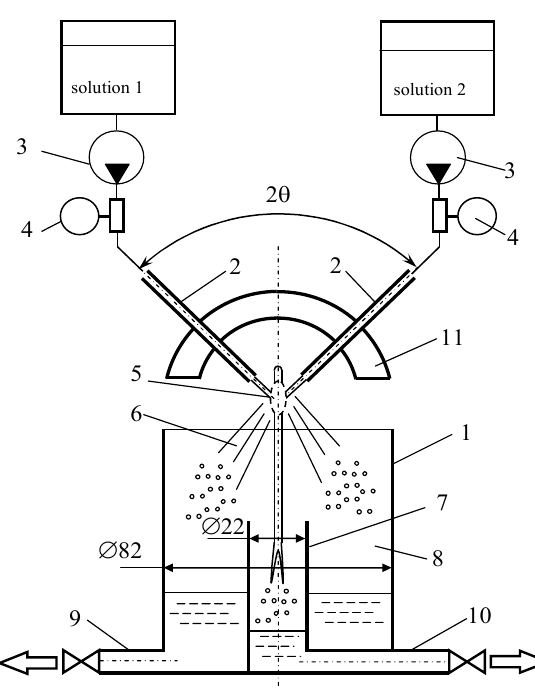
Figure 2. Photograph of the laboratory setup for studying the geometry and conditions for the formation and decomposition of the liquid sheet from open-frame MRFIJ. 2θ = 97.5°, d j = 1.0 mm. The distance between the nozzles is B = 25 mm. Distance from the exit from the nozzle to the point of collision L = 17 mm.